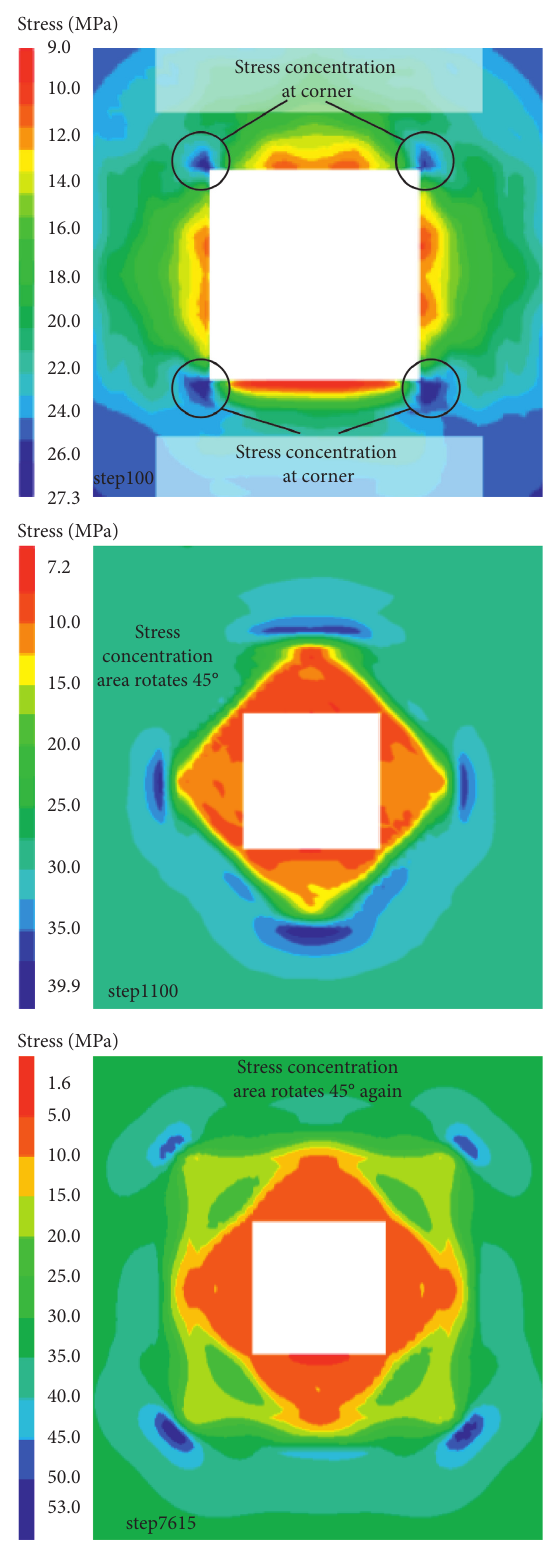
Figure 3: Evolution of compressive stress